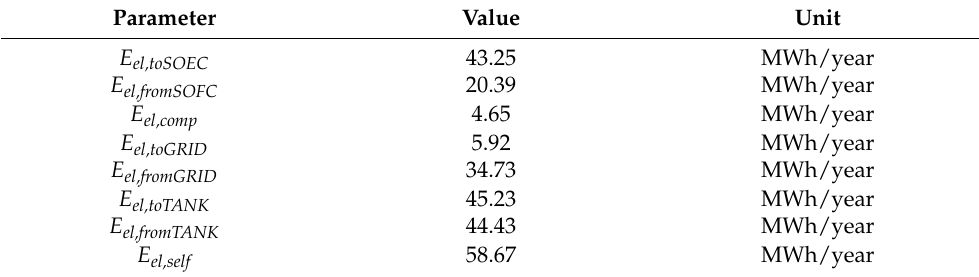
Table 4. Main results of the yearly dynamic